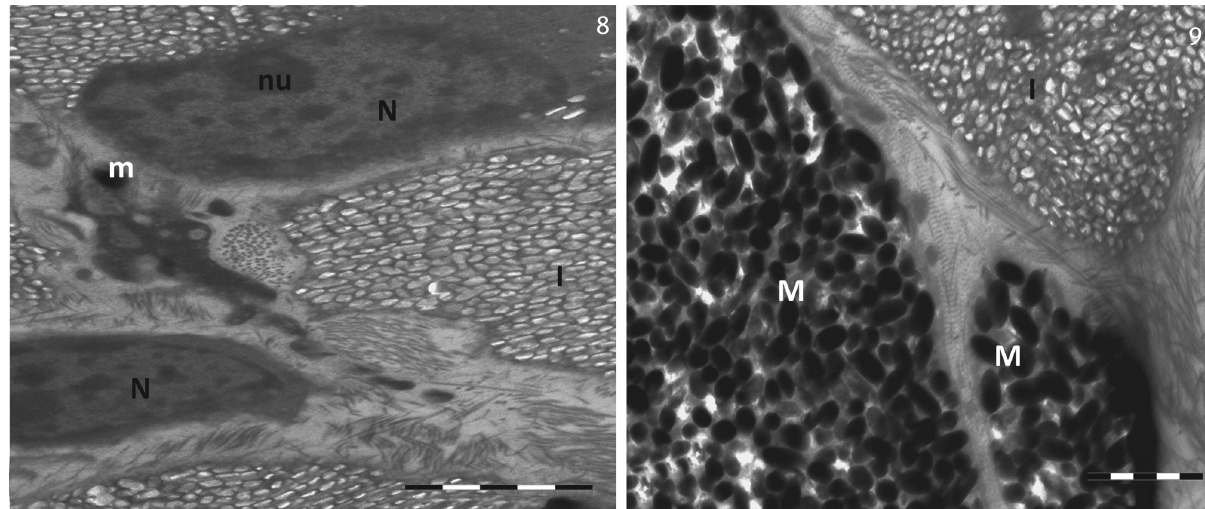
Figures 8–9. Electron photomicrograph showing different stages of melanosomes. (I) lridophores, (M) melanophores, (m) mitochondria, (N) nucleus, (nu) nucleolus. Scale bar: 2